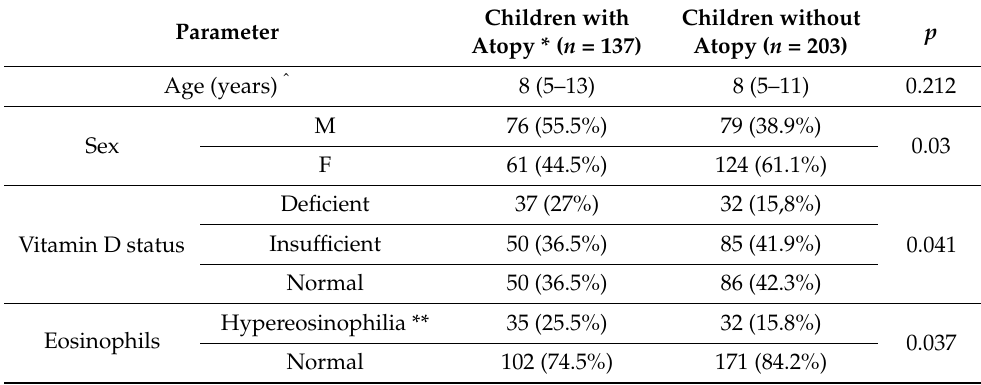
Table 1. Demographic characteristics and selected laboratory values in the study children with and without atopy